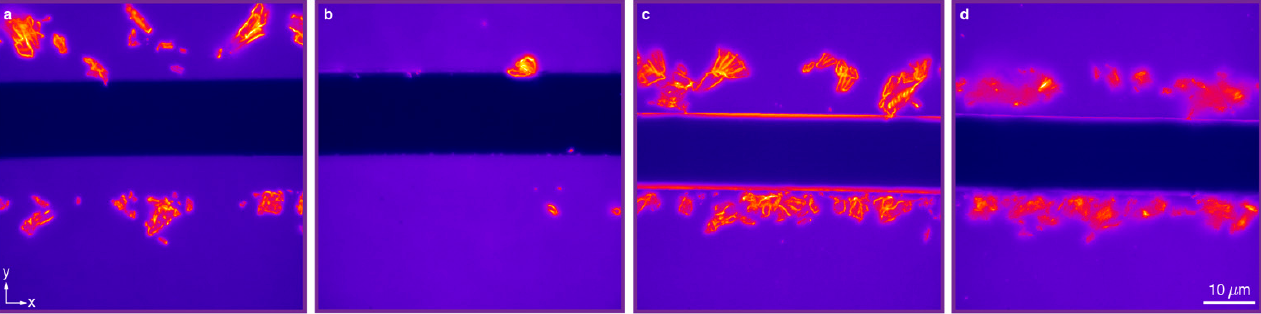
Figure 7. Measurement of the emission from a film of SNPs into air near an edge. ( a ) CMOS images of the fluorescence near the edge of a monolayer (left), a film with three layers (center) and a film with approximately eleven layers (right) of SNPs. ( b ) Single-photon counter measurement of the emission measured with a slit of 50 µm × 1 mm, corresponding to 0.5 µm on the substrate. Inset graph shows the atomic force microscopy (AFM) height profiles for the measured nanostructures. The experimental results summarized in Figure 7 allow evaluation of the importance of photoluminescence outcoupling and waveguiding in SNP films with different thicknesses. In general, microscopy-based observation of waveguiding inside a planar structure is problematic, unless the waveguide is strongly scattering. Our approach enables direct detection of waveguided light at the edge of the nanostructure, where part of the light is scattered into the observation cone of the high NA objective. For a monolayer and for a film of three SNP layers, mainly light outcoupled from the plane of the structure (Figure 7b) is observed, with intensity at most 50 photons per 10 ms. In contrast to the thinner films, the 11-layer SNP film waveguides a lot of the emission towards the edges leading to a peak of 160 photons per 10 ms (Figure 7b). This peak is asymmetric, with different features on both sides of the edge: the left side (y < 5 μ m) originates mainly from waveguided light and the right side is related to the peak of SNPs clustered at the boundary according to the AFM measurements in the inset of Figure 7b. Overall, the obtained experimental results are in agreement with our theoretical predictions (Equation (9), Figure 5a,b), revealing a strong dependence of photoluminescence waveguiding on the thickness of the SNP layer. Next, we characterized the properties of the photoluminescent light waveguided within the thick ( N = 11) film of SNPs. By using a polarizer in the imaging path of the